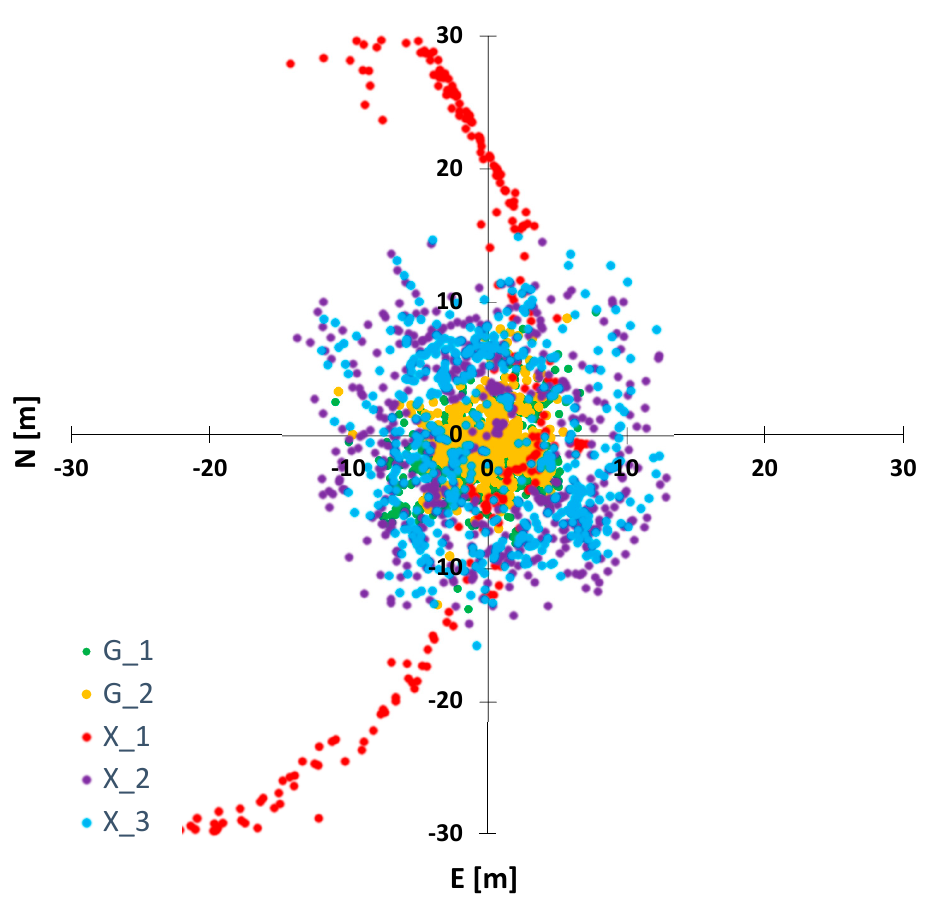
Figure 12. Plot of NE component deviations of surface measurements with code receivers. When analyzing the U-component deviation plot of the surface measurement (Figure 13), large error values were observed for receiver G_2, which ranged from 25 to 54 m. Receiver G_1 recorded data with an accuracy of 14 m, except for one larger error that reached 25 m. During altitude determination, a better measurement capability was guaranteed by the receiver using GPS (G_1) compared to the receiver using the GPS+GLONASS mode (G_2). This means,